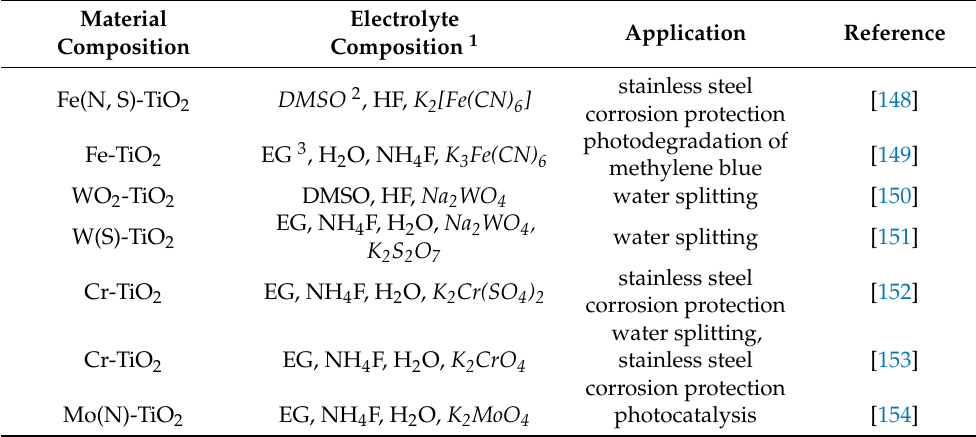
Table 1. Recent developments in TiO 2 doping with transition metals species in anodization of